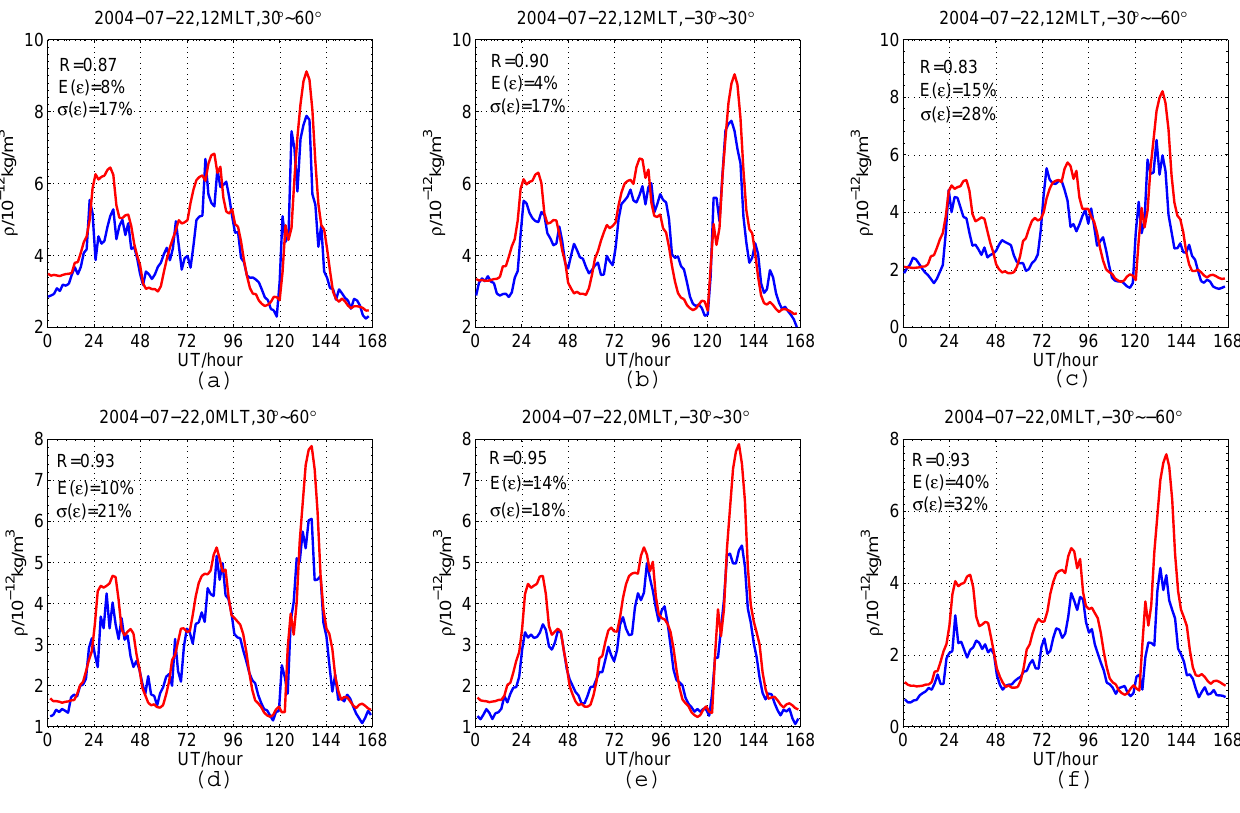
Fig. 7. The density prediction results of the storm series in 22–28 July 2004 using Eq. (11). The six panels represent the 6 latitude/MLT bins. The blue curve in each panel represents the density measurements from CHAMP and the red curve denotes the prediction. The correlation coefficient, R , between the measurement and prediction, as well as the mean and standard deviation of relative error E((cid:15)) and σ((cid:15)) , are given in each